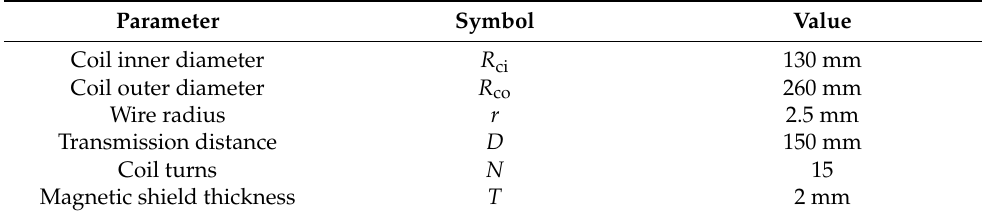
Figure 3. Coupling mechanism of WPT. Table 1. Main parameters of the coupling mechanism simulation model.